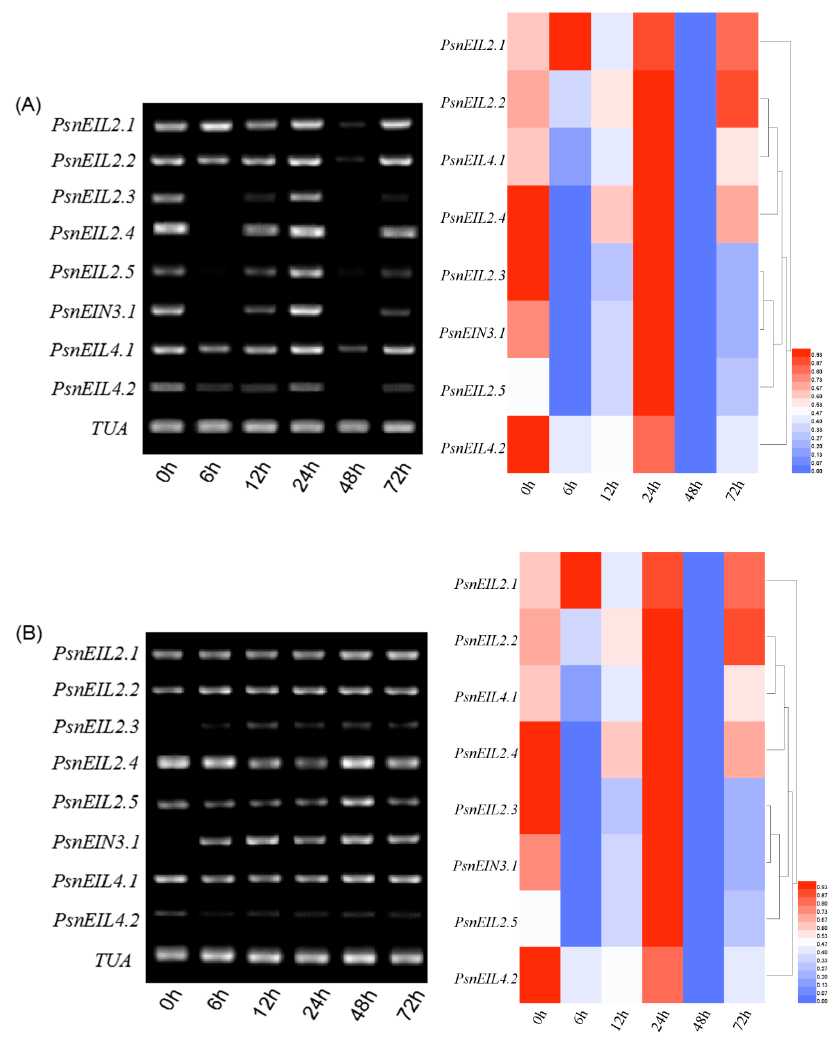
Figure 11. EIN3/EIL gene expression patterns of Populus × xiaohei under Nacl stress. Heat map showing the relative expression levels of PsnEIN3/EIL genes during salt damage treatment. sqRT-PCR was used to measure the transcription levels in root and leaf samples under stress treatment, and the data were normalized. ( A ) Roots. ( B ) Leaf. The color scale on the right of the heat map indicates the expression level: red indicates upregulation, and blue indicates